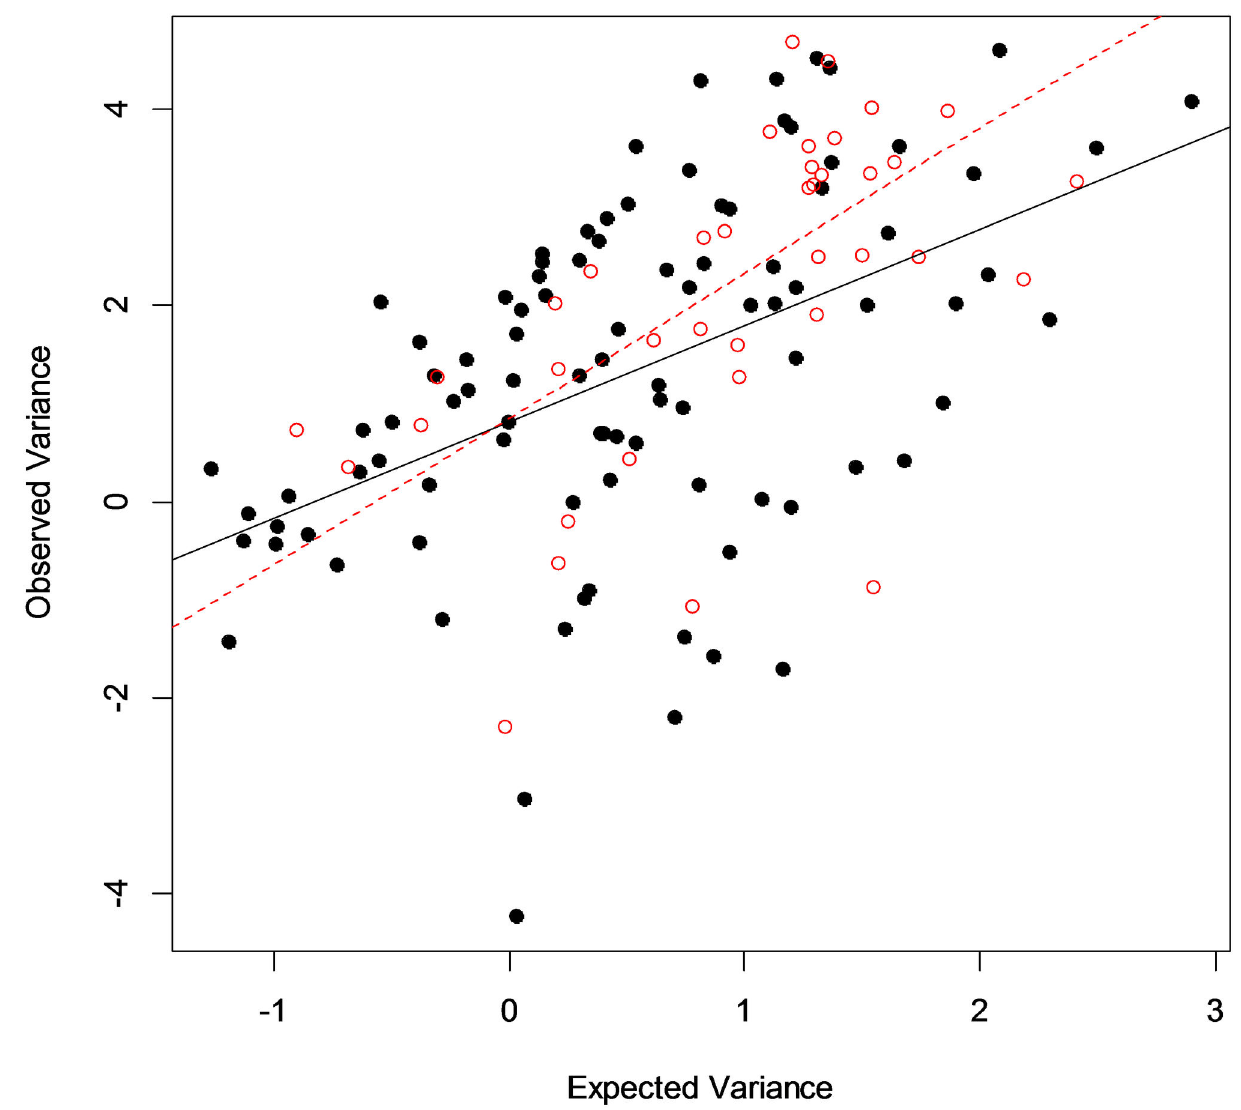
Figure 4. Differences in temporal variation between normal sites and hotspot clusters, measured by Taylor’s power law analysis. Sites in hotspot clusters (Text S1) are coded with open red circles, non-hotspot sites are coded with black filled circles. The dashed red line is the regression of expected versus observed site-level variance for hotspot cluster sites following the equation ln(V )=ln( A )+ b ln(V ), where the expected variance was calculated with the following formula: V obs bin proportion abnormal at a site, and n is the group size, or number of frogs sampled at each site (Text S1). Observed variance (V was calculated from repeated site visits using standard methods for estimating sample variance. For sites in hotspot clusters, the regression parameter estimates were ln( A )=0.84±0.36 (SEM) and b =1.48±0.28 (SEM). The slope of this line was significantly greater than one (t=1.73, with 39 df, p=0.046), implying significant aggregation, i.e., temporal variation dependent on the mean abnormality prevalence ( p ). For non-hotspot sites (solid black regression line) the parameter estimates for this relationship were ln( A )=0.81±0.18 (SEM) and b =0.98±0.18 (SEM). This slope was not significantly different than one (t=0.096, with 92 df, p=0.462) implying random temporal